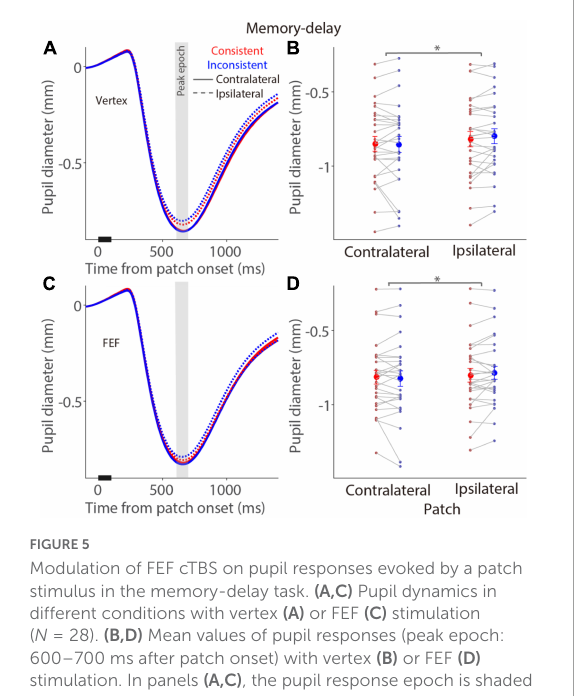
FIGURE4 Modulation of FEF cTBS on pupil responses evoked by a patch stimulus in the visual-delay task. (A,C) Pupil dynamics in different conditions with vertex (A) or FEF (C) stimulation ( N = 28). (B,D) Mean values of pupil responses (peak epoch: 600–700 ms after patch onset) with vertex (B) or FEF (D) stimulation. In panels (A,C) , the pupil response epoch is shaded in gray. The black bar on X-axis indicates the time line of patch presentation. In panels (B,D) , the large-circle and error-bars represent the mean values ± standard error across participants. The dots represent mean value for each participant. Contralateral: contralateral stimulus condition (left). Ipsilateral: ipsilateral stimulus condition (right).